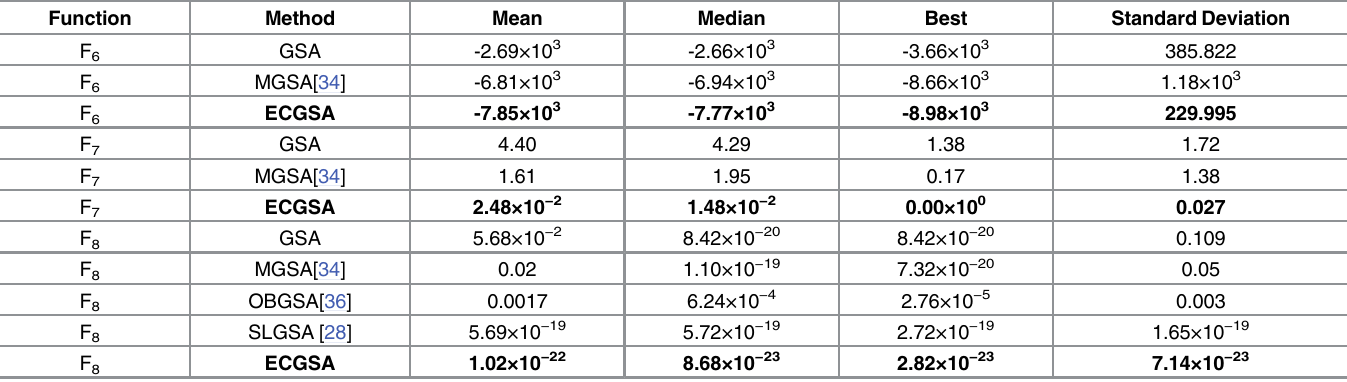
Table 4. Minimization result of multimodal benchmark functions in Table